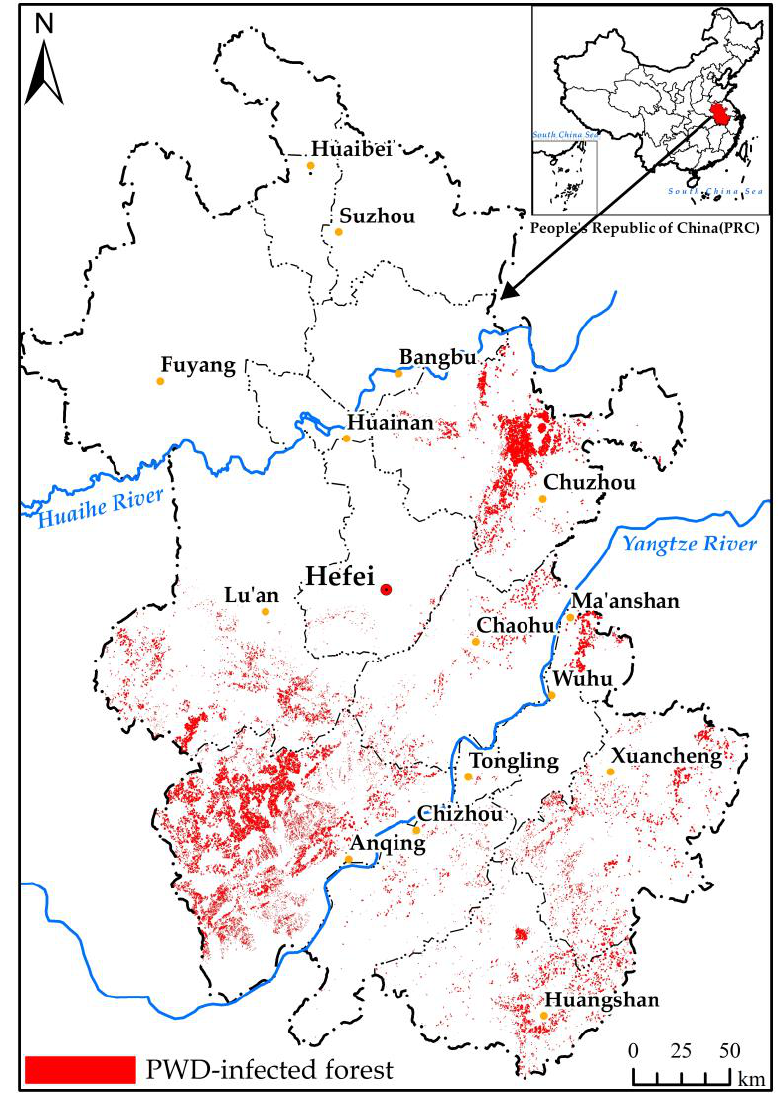
Figure 7. Spatial distribution of PWD in Anhui Province (superposition of 4 periods).